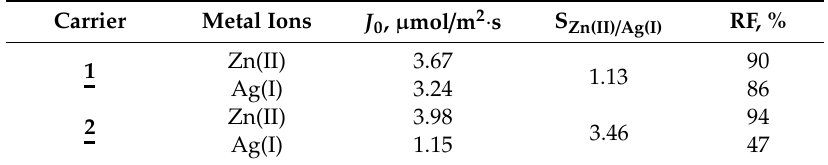
Table6. Initialfluxes( J 0 ),selectivitycoefficients(S),andrecoverycoefficients( RF